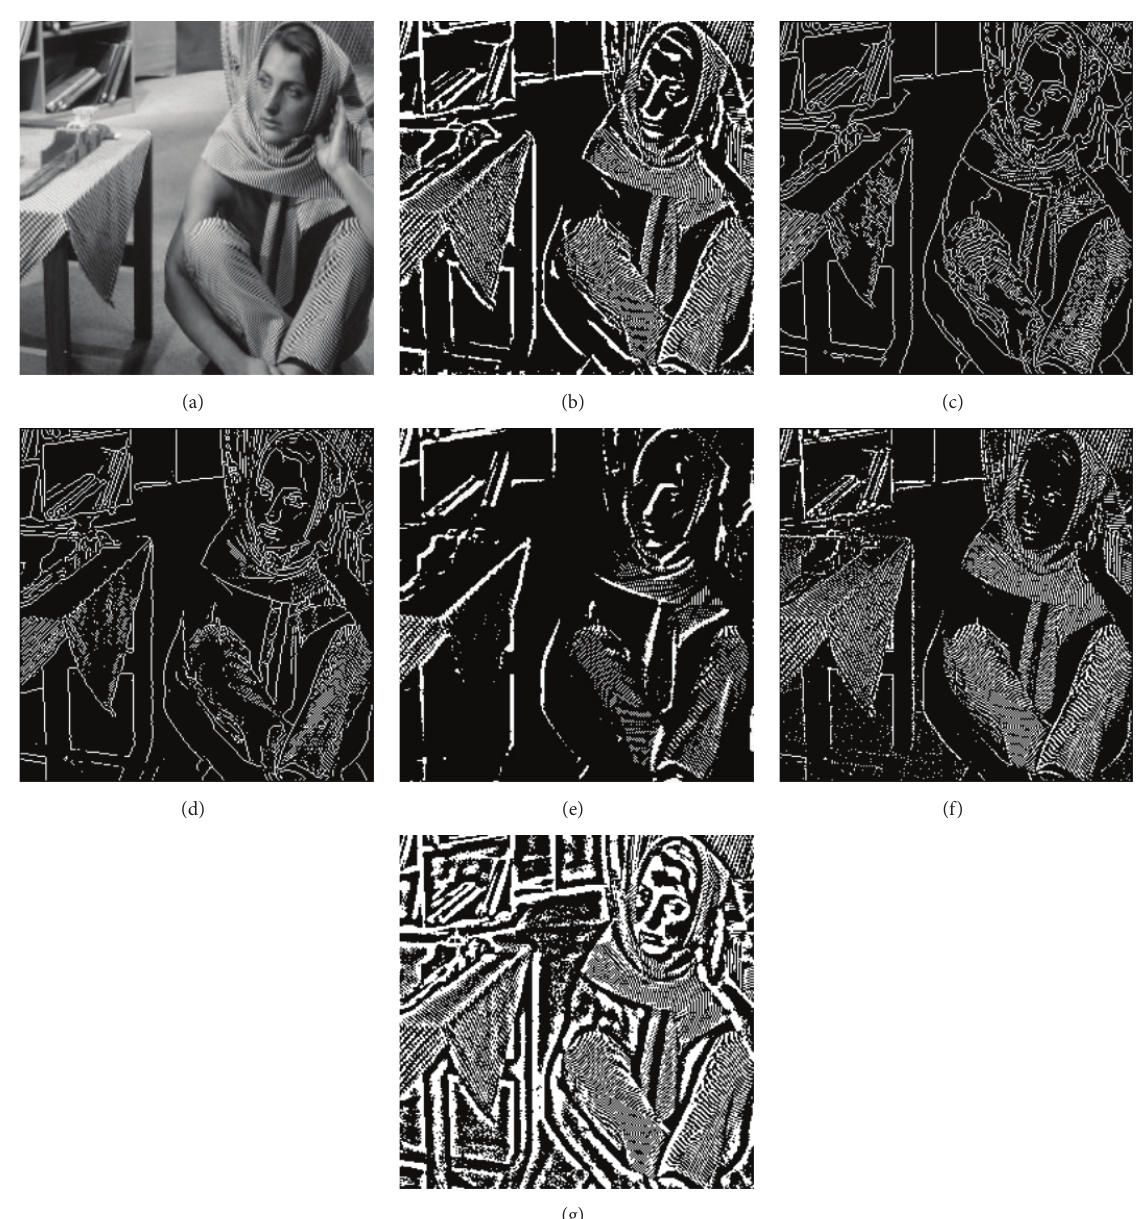
Figure 5: Edge detection results: (a) original image; (b) the result by Canny; (c) the result by our method; (d) the result by Sobel; (e) the result by wavelet method; (f) the method based on CNN; (g) NSCT